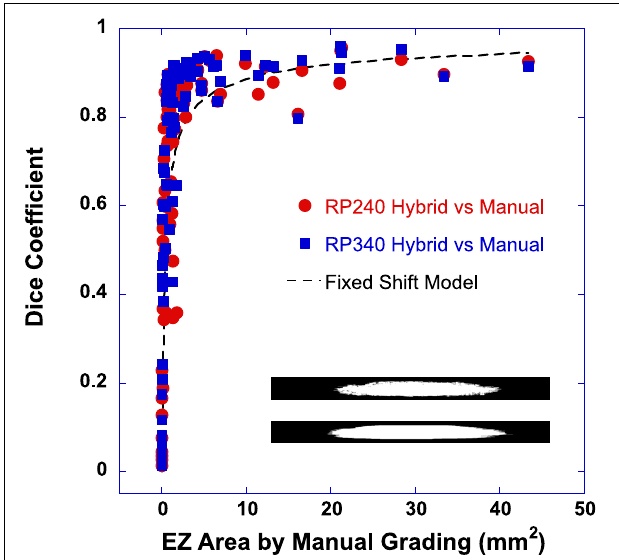
FIGURE 1 | Dice similarity coefficient was plotted as a function of ellipsoid zone (EZ) area determined by the manual grading of the reading center. Close red circles were the dice coefficients between the EZ band area determined by the RP240 hybrid model and that by the manual grading. Closed blue squares were the dice coefficients between the EZ band areas determined by the RP340 hybrid model and the manual grading. The inset images (121 × 1,536 pixels) showed two examples of EZ band segmentations of 121 B-scan lines used for pixel-wise comparison to obtain the dice coefficient (top: by RP340 hybrid model; bottom: by manual grading of the reading center). The dashed line is the output of a simple fixed shift model for dice coefficient between two same size circles. In this example, the constant lateral shift between two circles was 55 pixels (0.315